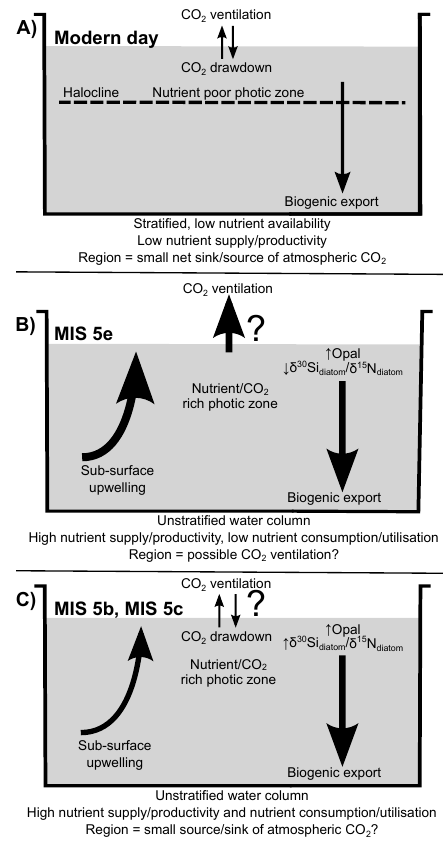
Figure 4. Schematic models showing subarctic north-west Pacific Ocean conditions for (a) modern day: halocline water column with nutrient poor surface waters limiting biological export; (b) MIS 5e: no halocline and enhanced upwelling of nutrient- and carbon-rich sub-surface waters leading to increased productivity. Low rates of nutrient utilisation suggest a possible increase in p CO 2 and release of CO 2 to the atmosphere; (c) MIS 5b/c: conditions similar to MIS 5e but with higher rates of nutrient consumption and a more efficient soft-tissue biological pump limiting/preventing ventilation of CO 2